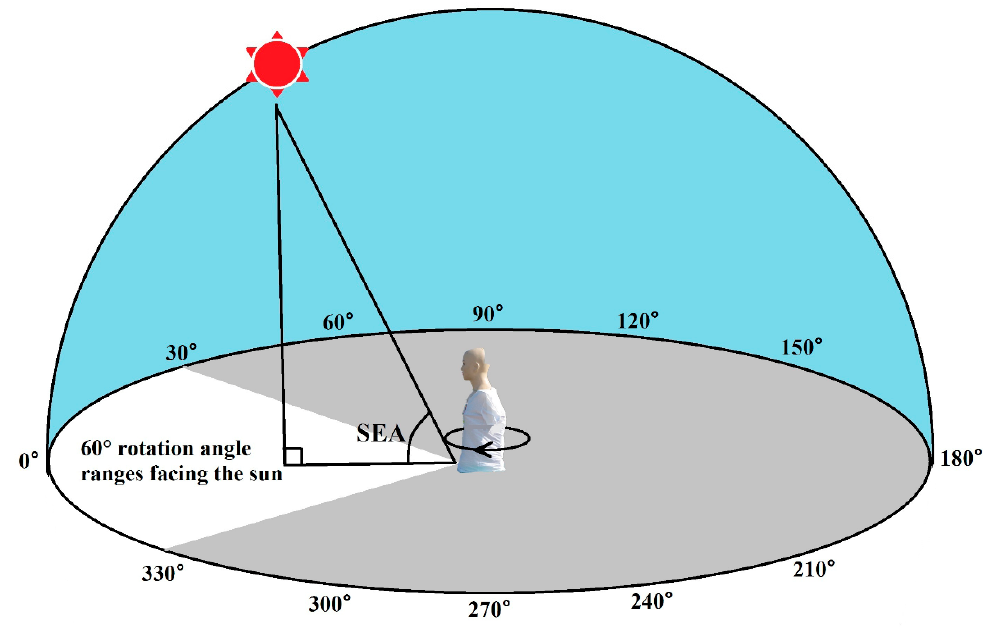
Figure 2. UV measurements for different rotation angles. Notes: Rotation angle of 0° is the initial position of the rotating model facing the sun. The rotation angles are increased clockwise. In this figure, we show 12 rotation angles at 30° intervals. Based on the rotation angles, the rotation angle ranges were determined. For example, the 60° rotation angle range facing the sun was comprised of the rotation angles from 330° to 30° rotated clockwise, shown in white in this figure. The solar elevation angle (SEA) is the angle complementary to the solar zenith angle. The solar zenith angle is the angle between the line of the sun and the model with the line vertical to the ground.